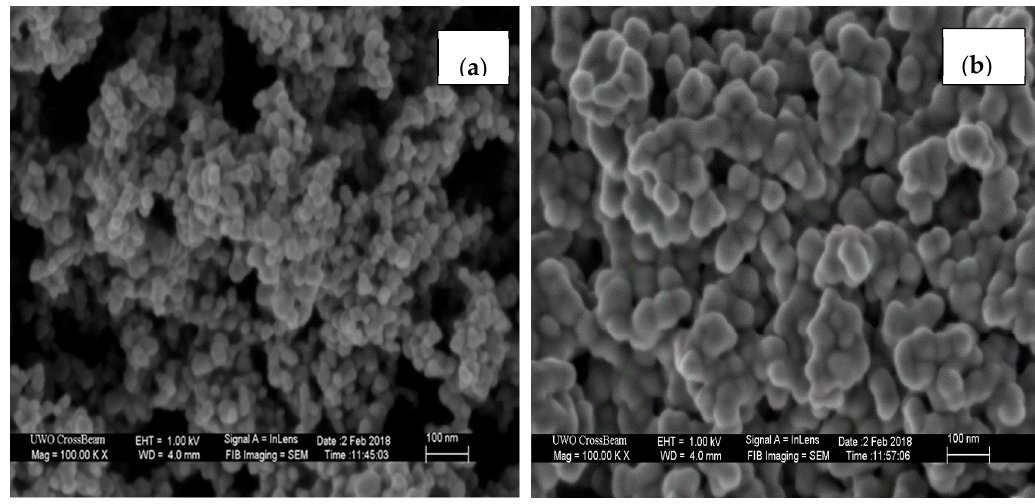
Figure 2. SEM picture of ( a ) aeroxide TiO 2 and ( b ) MS-TiO 2.